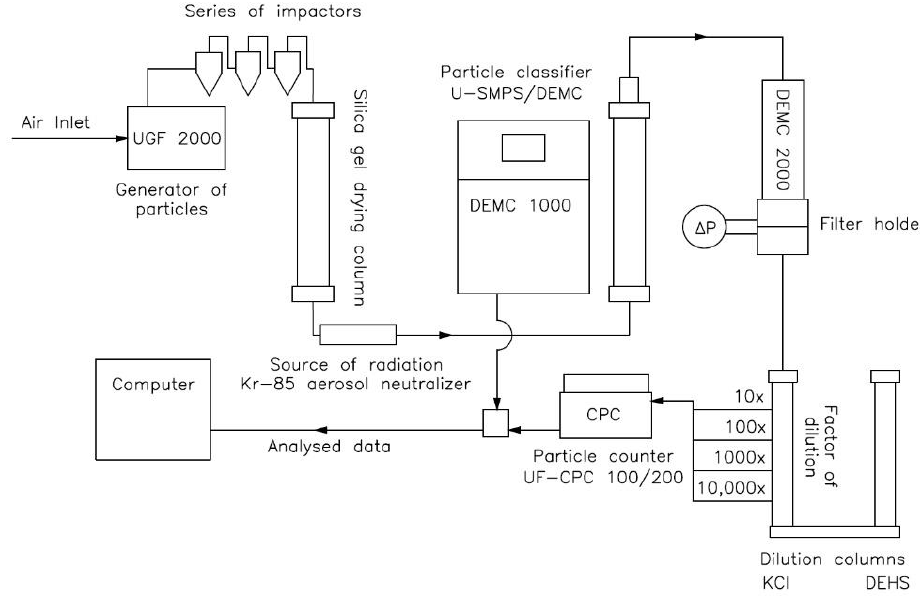
Figure 5. Test bench for testing flat filtration materials.